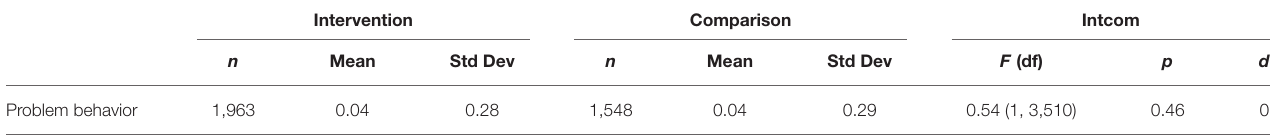
TABLE 8 | Change in a sum variable called problem behavior that combined items concerning bullying, substance abuse and truancy.